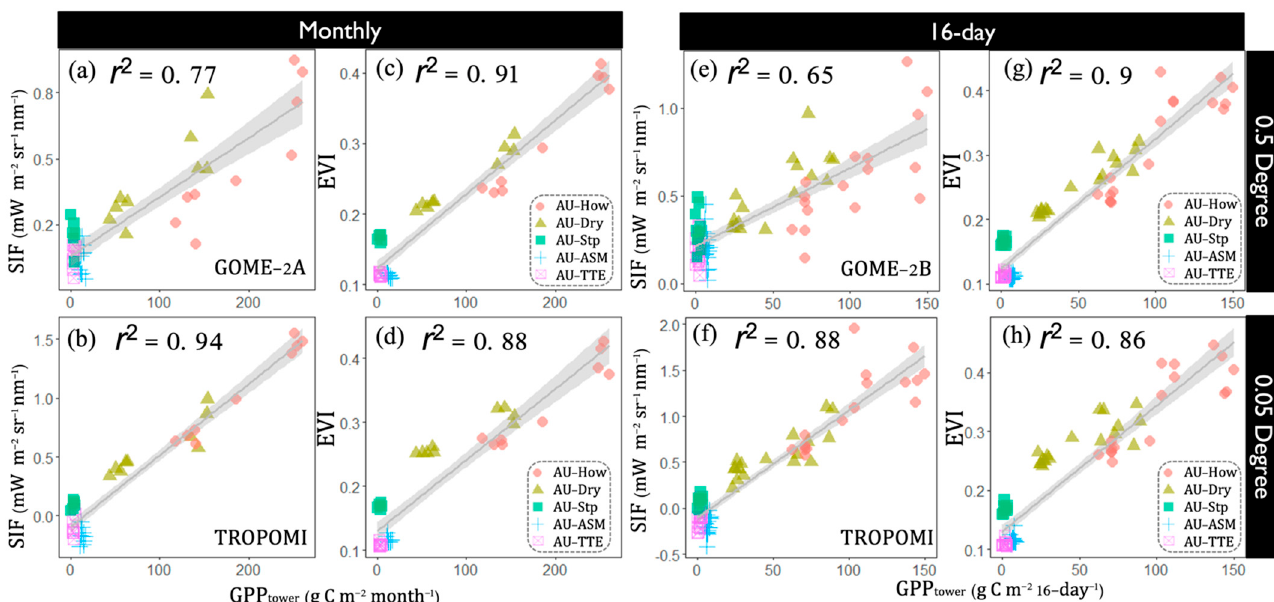
Figure 9. ( a – h ) Relationship between tower-based GPP and satellite-based SIF, EVI in 2018–2019 across five flux tower sites at different spatial (0.5°, 0.05° grid) and temporal (monthly, 16-day) resolution. The bottom-right embedded box shows the legend of the five flux tower sites. ( p value < 0.001) .